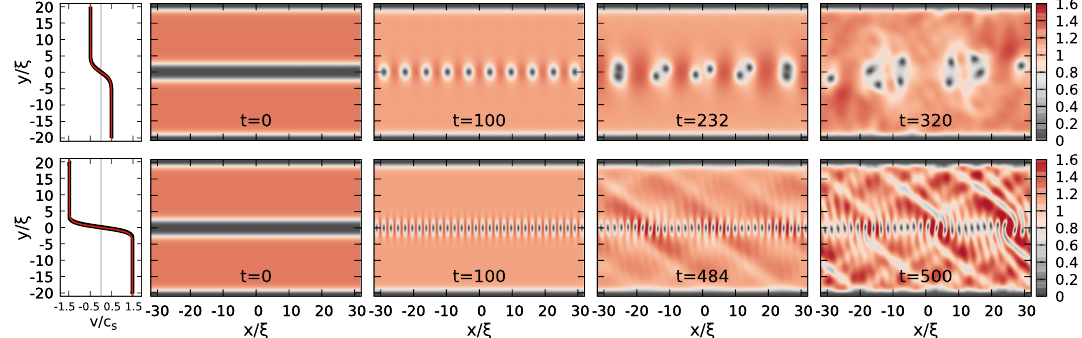
Figure 1: GPE simulations of the time evolutions of the density of a condensate con- / 2, with L = 40 ξ and with a central Gaus- fined along y by hard walls at y = ± L y y = A exp ( − y 2 / 2 σ 2 ) with A = 5 µ and σ = ξ . Opposite velocities sian potential V G ± v = ± ∆ v / 2 are imposed in the two regions y < 0 and y > 0 and, when the Gaus- sian potential is progressively lowered (between t = 0 and t = 100 µ/ ħ h ), an array of quantized vortices develops. The upper plots show the case ∆ v = 0.98 c and s the lower ones ∆ v = 2.94 c . In the leftmost panels we show cuts of the velocity s profile along y for a x = 32 ξ position located in between a pair of vortices for time t = 100 µ/ ħ h after the formation of the array of vortices: the thicker black lines show the numerical data, the thinner red lines are plots of equation (3), with the shear layer width (4). The upper panels show the KHI behaviour presented in [ 19 ] , in which vortices cluster and co-rotate. The lower panels show an example of SRI, in which the instability is slower and the unstable mode is not localized on the vortex line, but is distributed all over the system. Times are expressed in units of ħ h /µ . A video of these evolutions is available online [ 25 ]